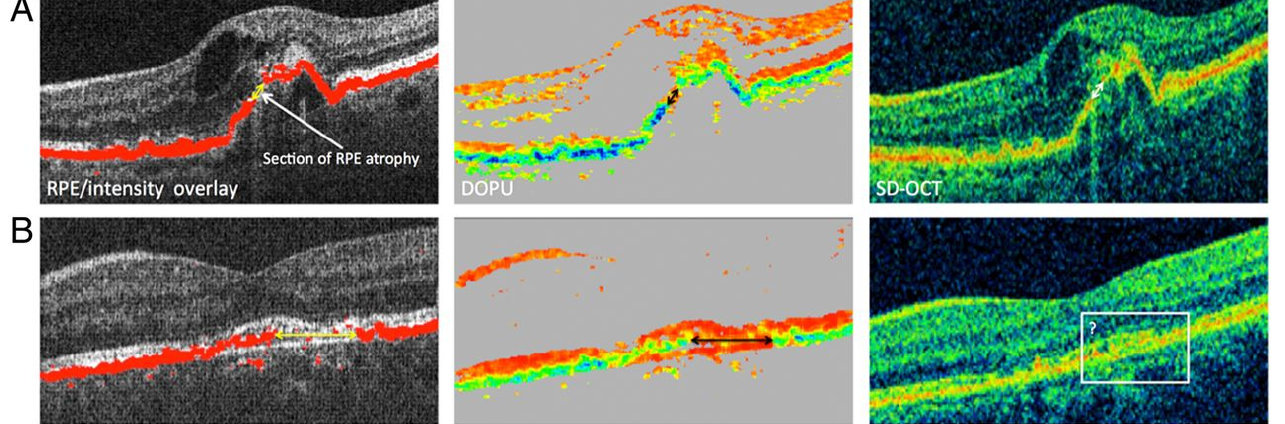
Figure 4. Polarization-sensitive optical coherence tomography (PS-OCT). ( A ) Three-figure panel showcases a comparison of PS-OCT ( top middle ) and SD-OCT ( top right ) where both modalities are able to identify retinal pigment epithelium atrophy. ( B ) Three-figure panel showcases a com- parison of PS-OCT ( bottom middle ) and SD-OCT (bottom right) where PS-OCT can more clearly identify the retinal pigment epithelium atrophy. Reprinted with permission from Schütze, C et al. Polarisation-sensitive OCT is useful for evaluating retinal pigment epithelial lesions in patients with neovascular AMD. British Journal of Ophthalmology 2016; 100: 371–377 with license permissions obtained from Creative Commons; Attribution-NonCommercial 4.0 International (CC BY-NC 4.0, https://creativecommons.org/licenses/by-nc/4.0/legalcode (accessed on 1 August